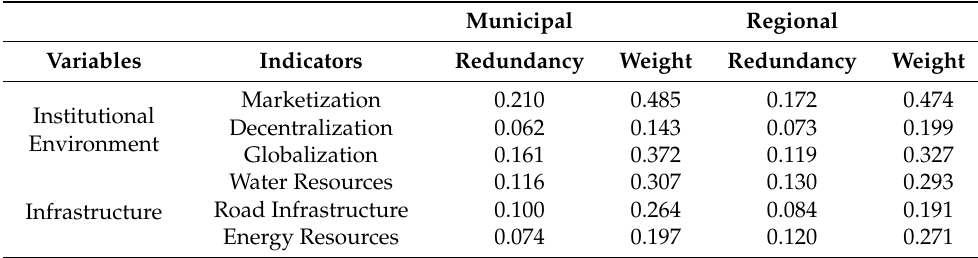
Table 2. The result of the entropy analysis of institutional environments and infrastructure.